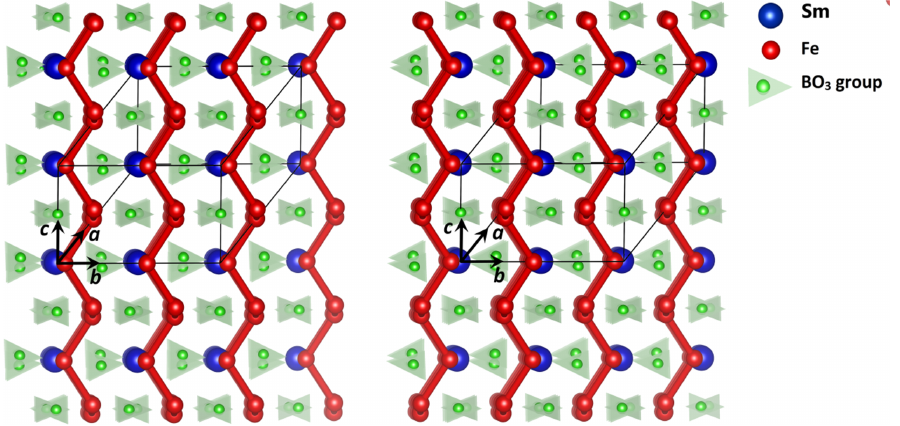
Figure 2. View of left-handed and right-handed structures for SmFe 3 (BO 3 ) 4